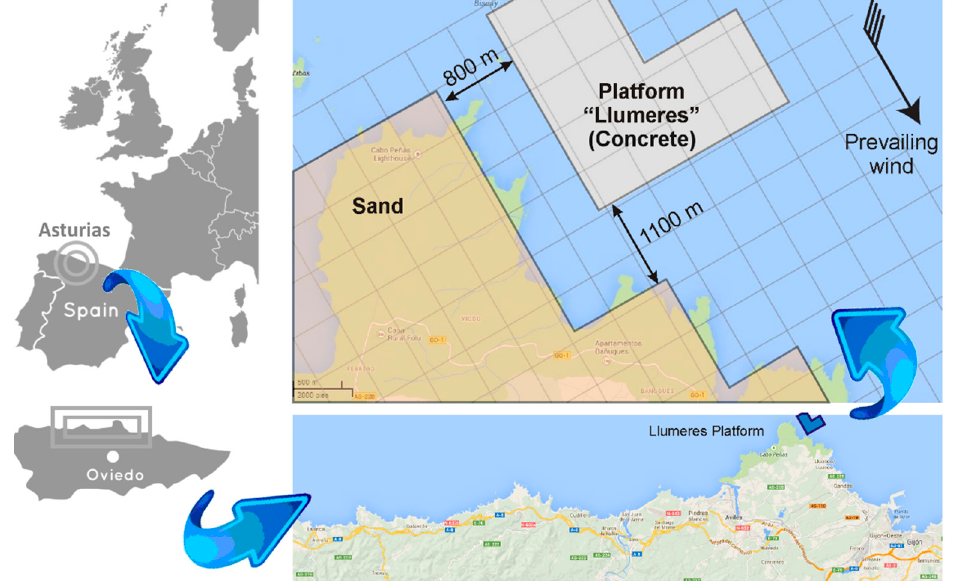
Figure 2. Location of the Llumeres platform and simulated geometry.